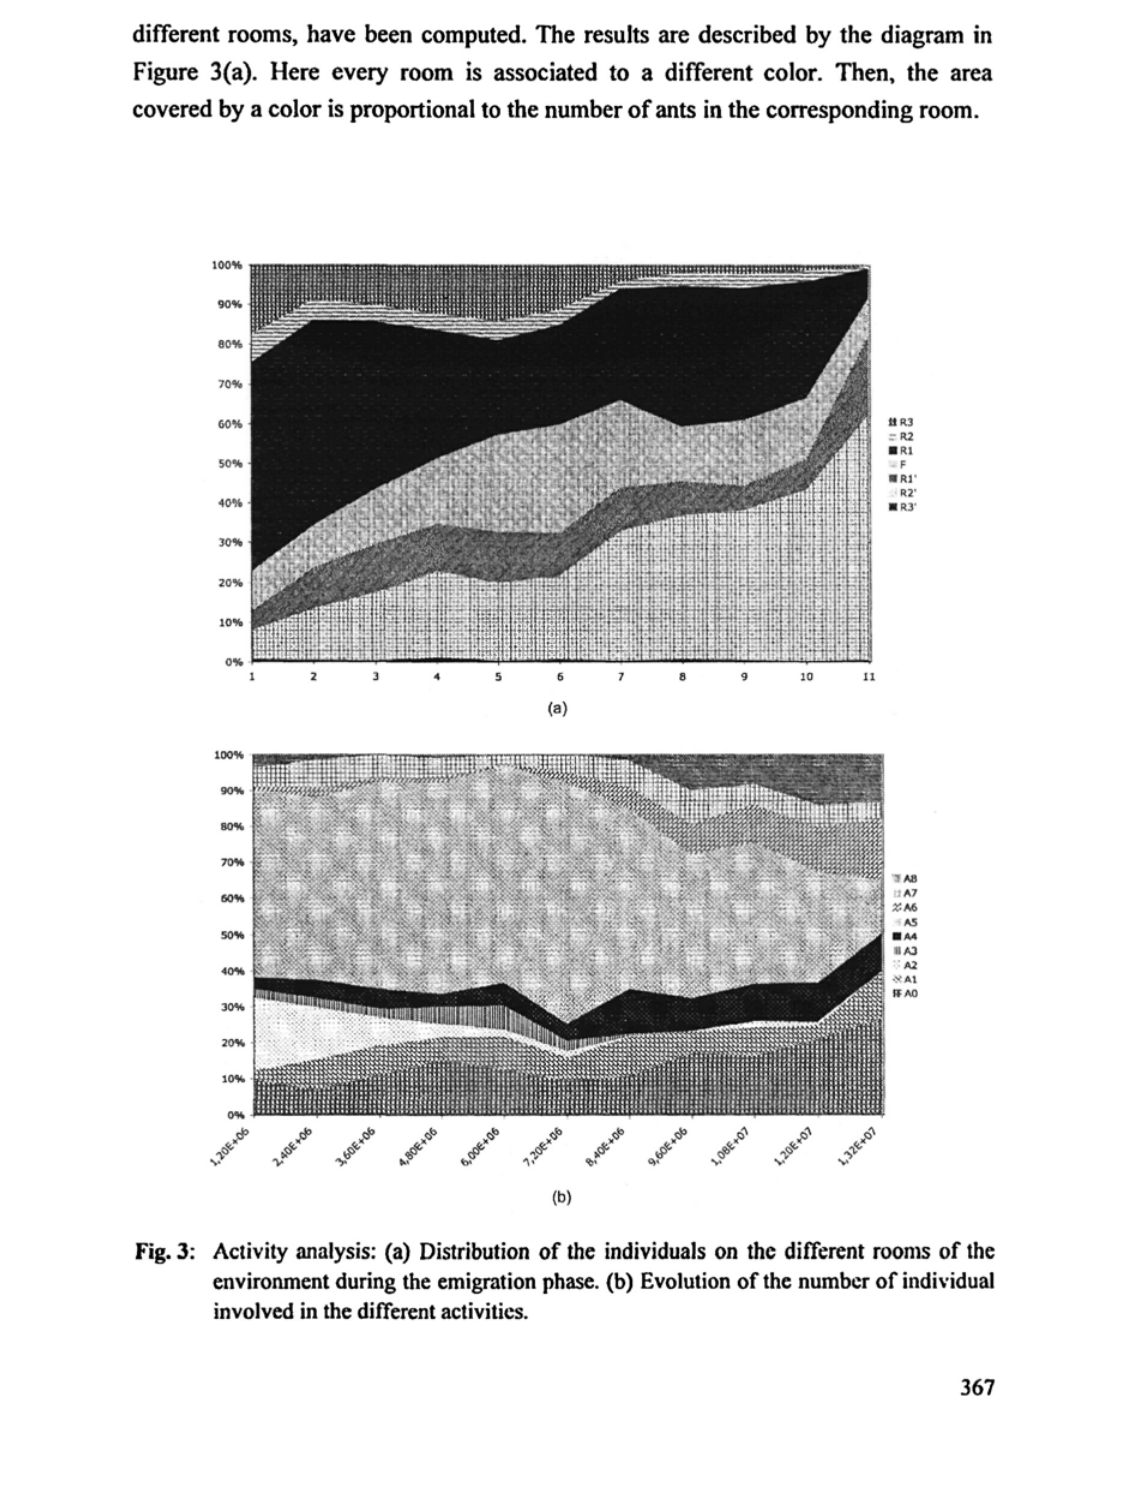
Fig. 3: Activity analysis: (a) Distribution of the individuals on the different rooms of the environment during the emigration phase, (b) Evolution of the number of individual involved in the different